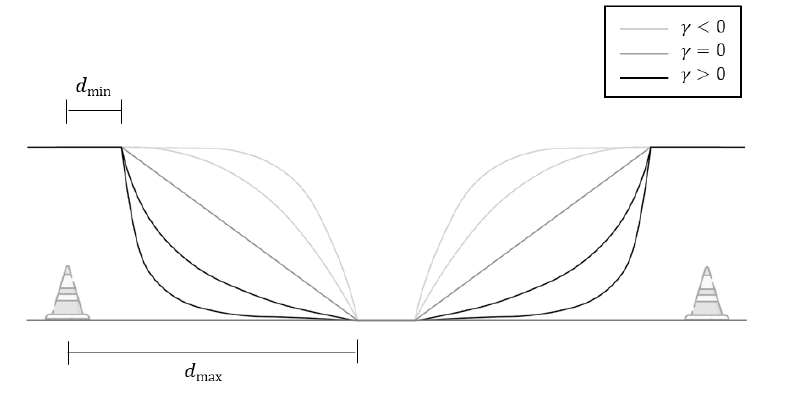
Figure 6. Evolution of U with d for several values of γ : the higher the value of γ , the lower the danger of the boundary. In this figure, two different potential fields are represented, one for each limit. As such, U increases from bottom to top ( ↑ ) for both limits, but d increases from left to right ( → ) for the left limit and from right to left ( ← ) for the right